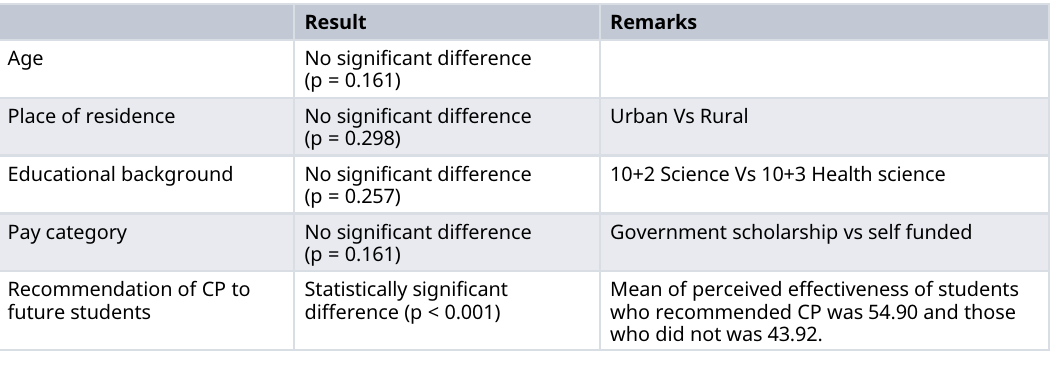
Table 2. Comparison between total score and demographic variables of students based on the perception questionnaire for students.